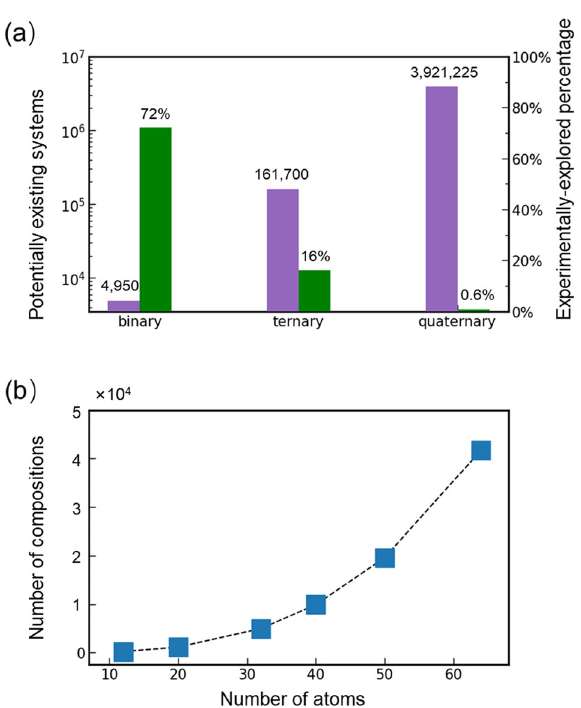
Fig. 1 Number of potentially existing complex systems and compositions. a The number of binary, ternary and quaternary systems and the percentage of experimentally studied systems at normal conditions. b The number of compositions as a function of the number of atoms in the unit cell of a ternary